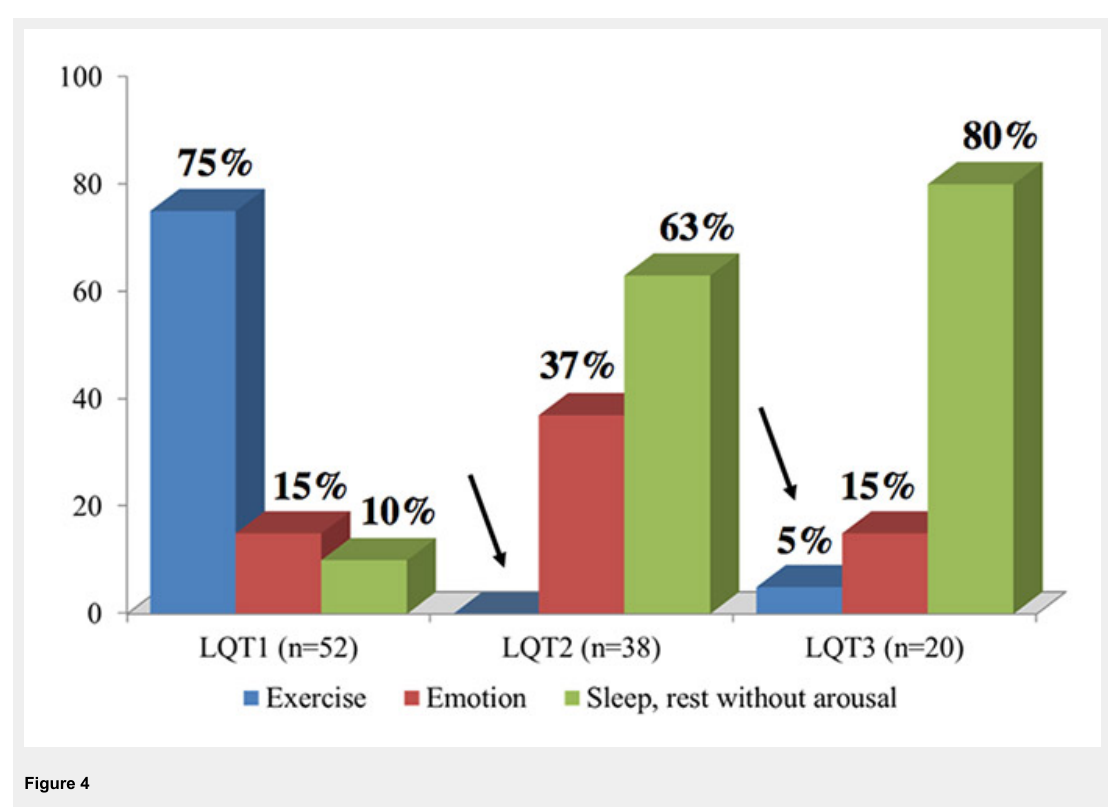
Figure 4 Triggers for lethal cardiac events in LQT1, LQT2 and LQT3 patients. The arrows indicate the rare occurrence of these events during sympathetic activation in patients without mutations affecting the I Ks current. (Modified from reference